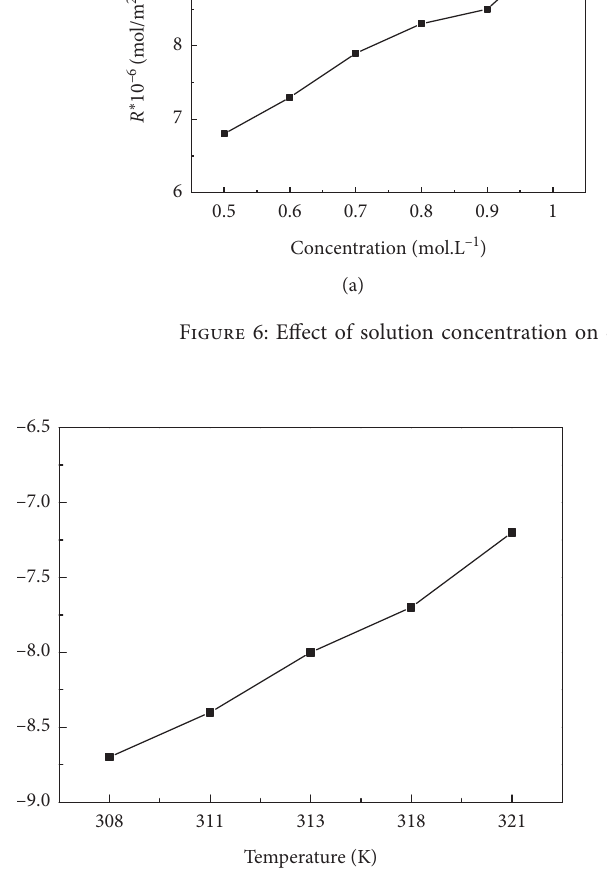
Figure 7: Effect of different temperatures on extraction rate constants. Table 2: Parameters of the extraction rate for equation (15). Circulation flow rate